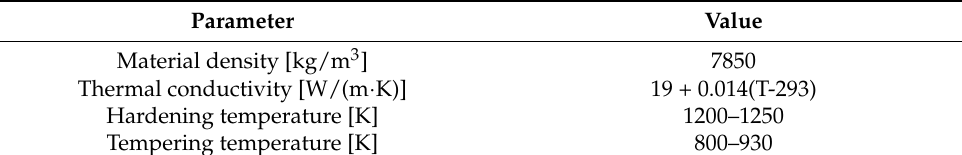
Table 10. Barrel material thermophysical properties and values of temperature of processes.